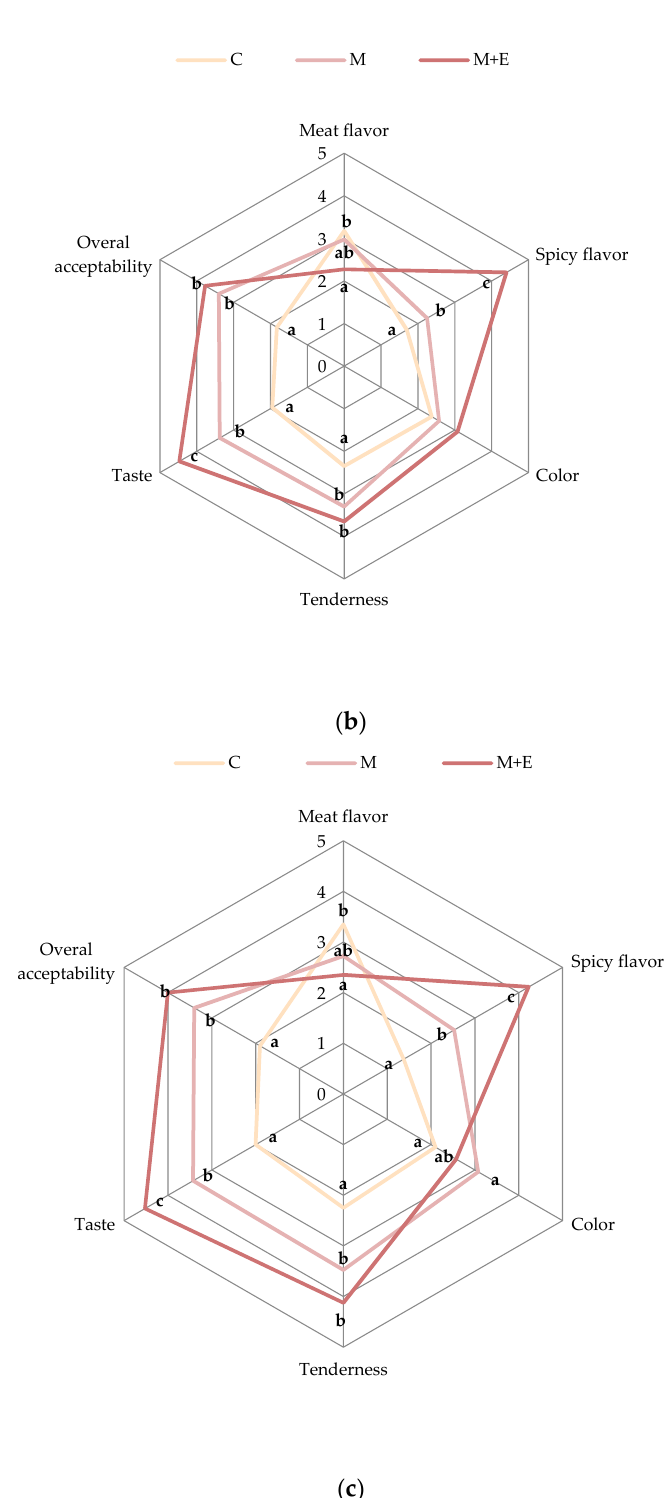
Figure 6. Sensory data of pork loin slices after 3 days ( a ), 9 days ( b ) and 15 days ( c ) of storage in relation to the sample (Control (C), Marinated (M), marinated with essential oils (M + E)). Data represent means ± SD. a, b, c = average values of each sensorial parameter lacking a common letter significantly differ among the same sensory parameter.